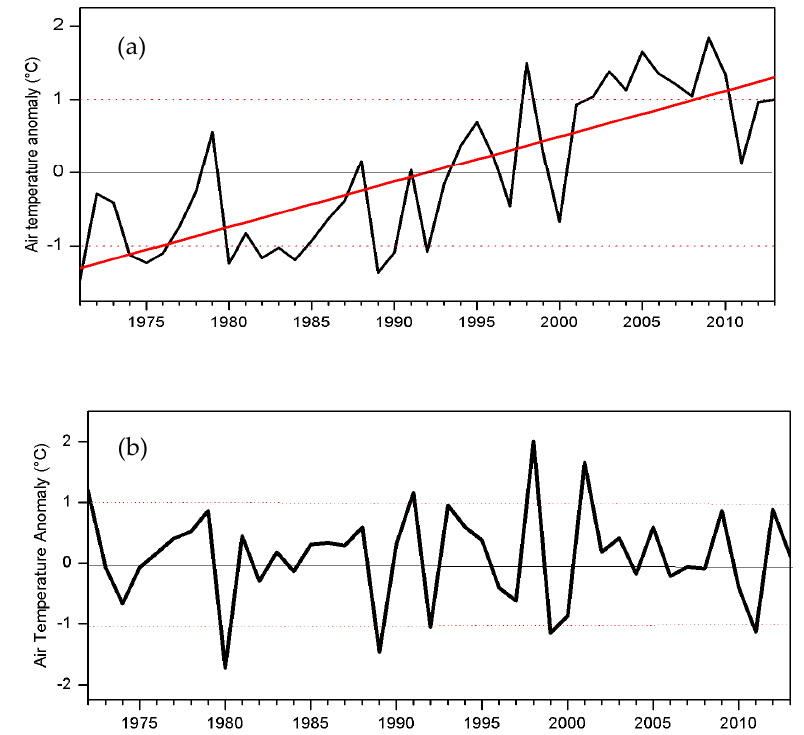
Figure 4. ( a ) Time series of annual mean air temperature anomalies and its linear trend (solid red line); ( b ) detrended time series of annual mean air temperature anomalies.